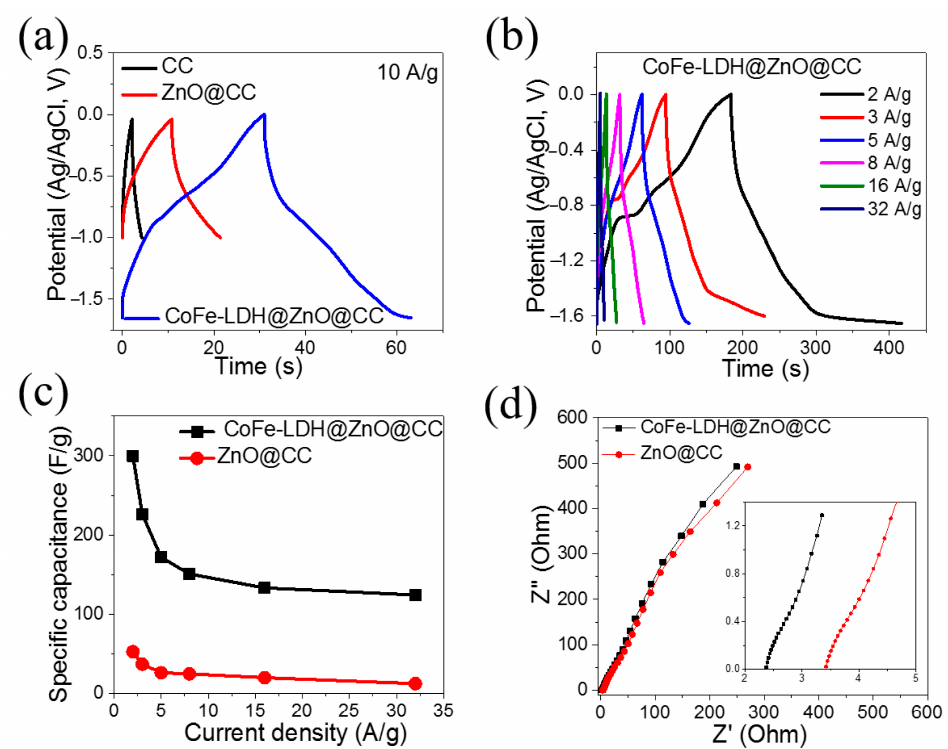
Figure 6. ( a ) GCD profiles of CC, ZnO@CC, and CoFe-LDH@ZnO@CC; ( b ) GCD profiles of CoFe-